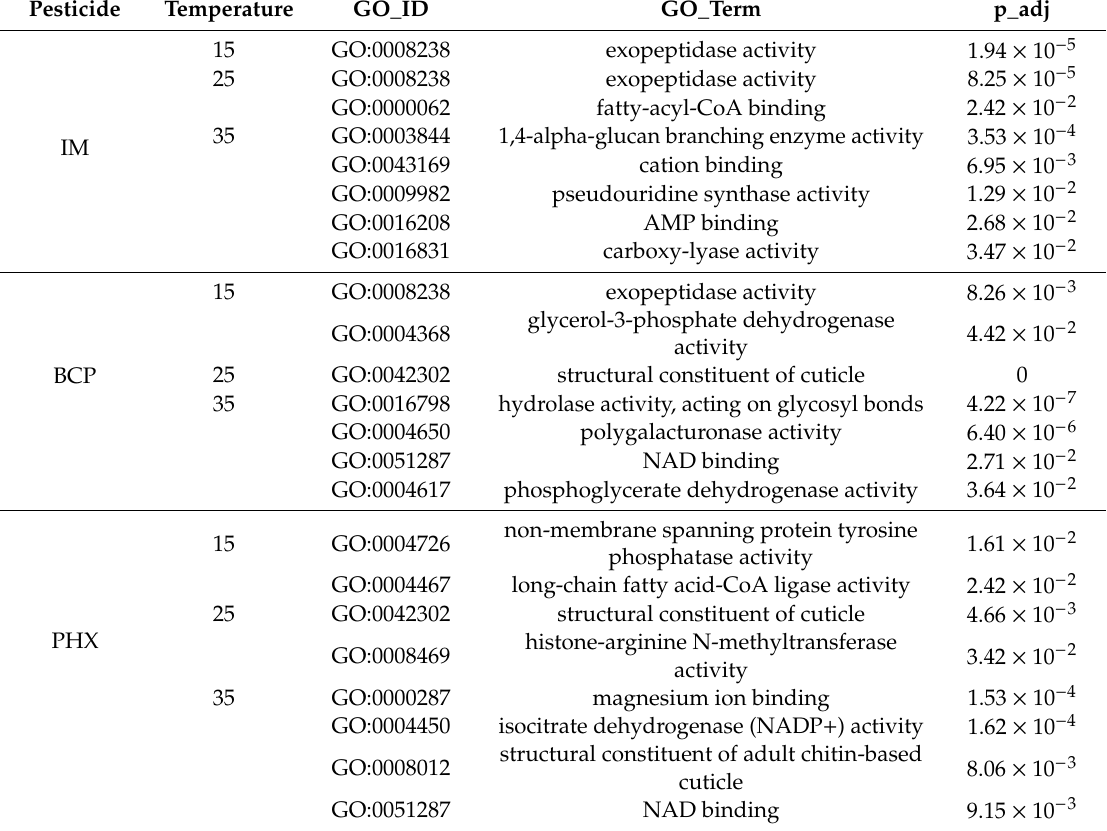
Table 2. GO enrichment analysis of up-regulated transcripts after treatment with di ff erent insecticides at di ff erent